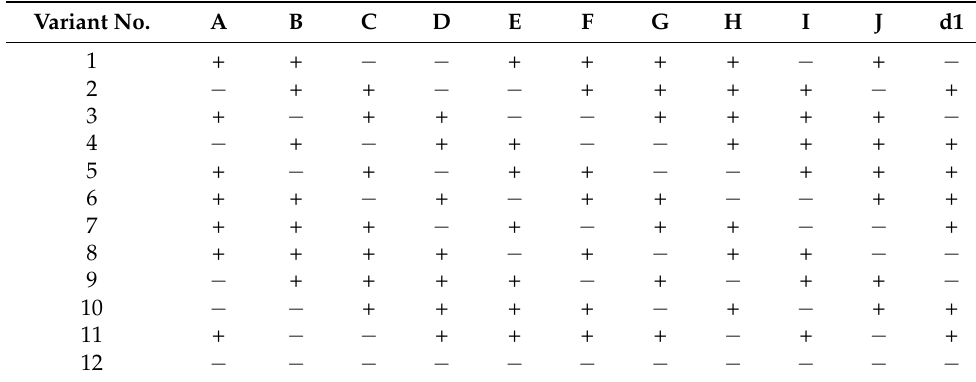
Table 3. Variable combinations of the Plackett–Burman design. Variant